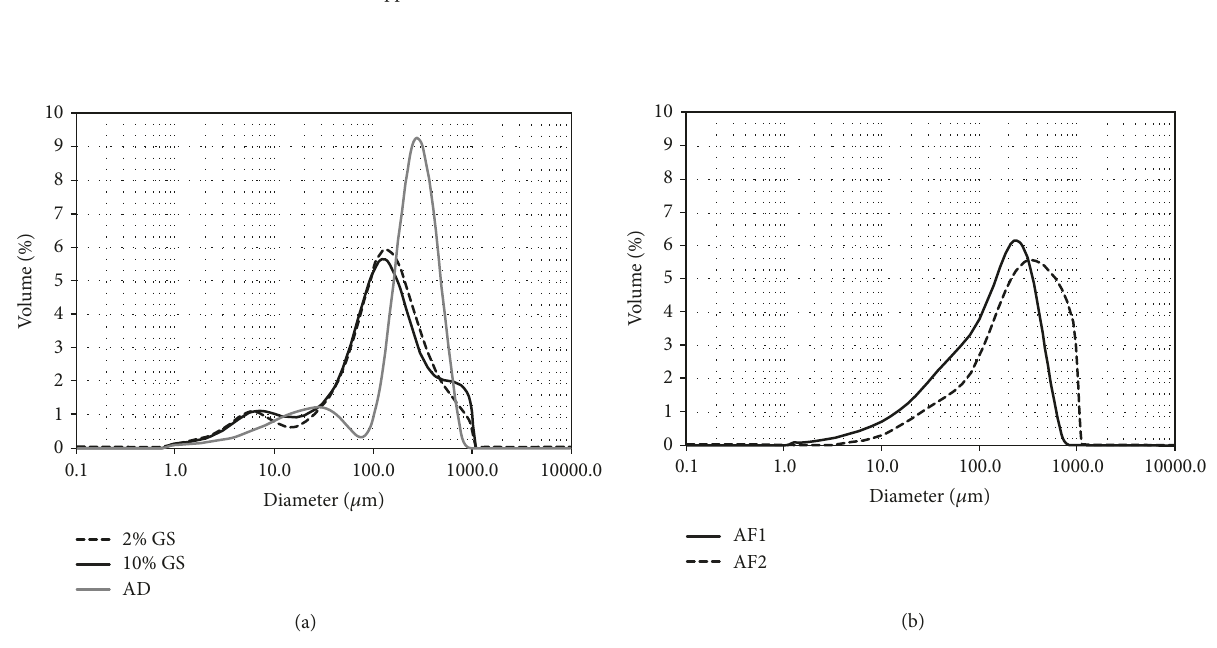
Figure 1: Particle size distribution of semiliquid 2% and 10% GS samples and air-dried GS [(a): 2% GS, 10% GS, and AD] and commercial apple skin samples [(b): AF1 and